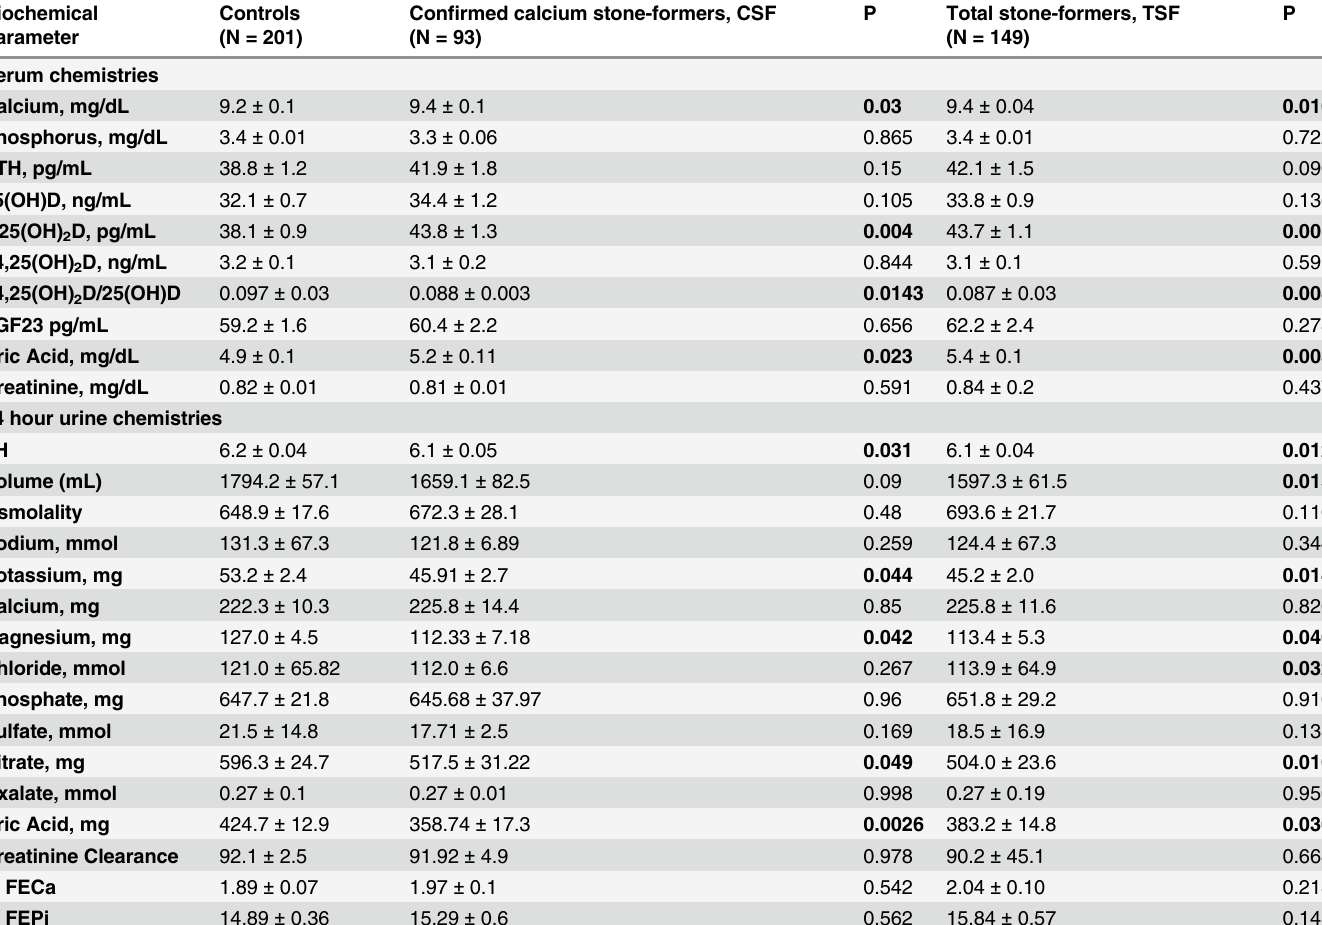
Table 1. Serum analytes and hormones (PTH, 25(OH)D, 1,25(OH) 2 D, 24,25(OH) 2 D and FGF-23) and urine analytes in calcium stone-formers and controls. All values are represented as mean ± standard error. CSF = confirmed; TSF = total (confirmed plus presumed calcium